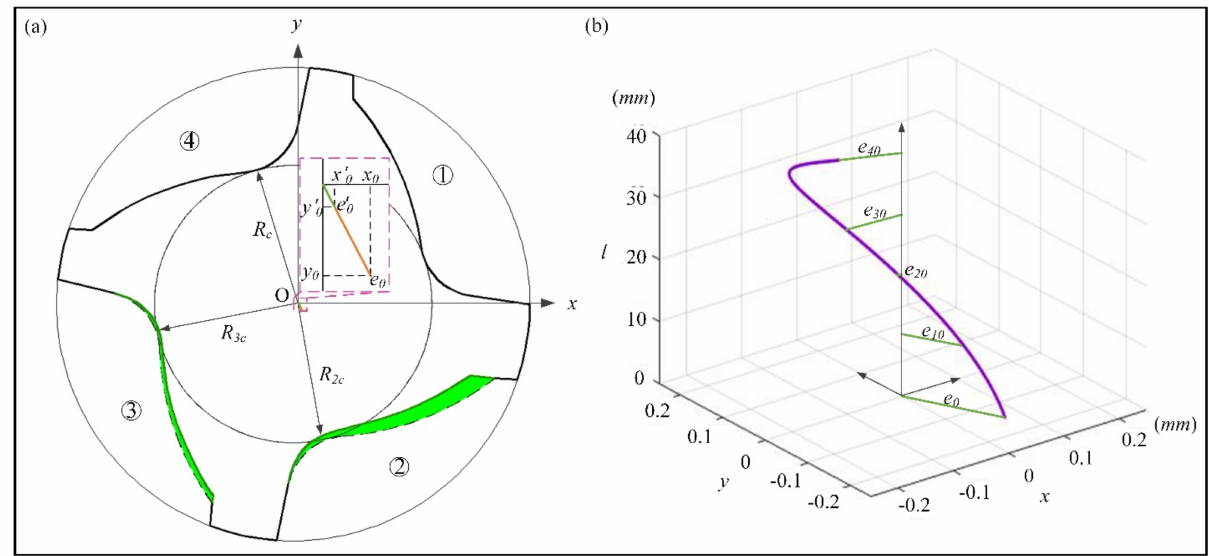
Figure 7. Centroid distribution of optimized variable pitch end mill: ( a ) end section; ( b ) cutting edge